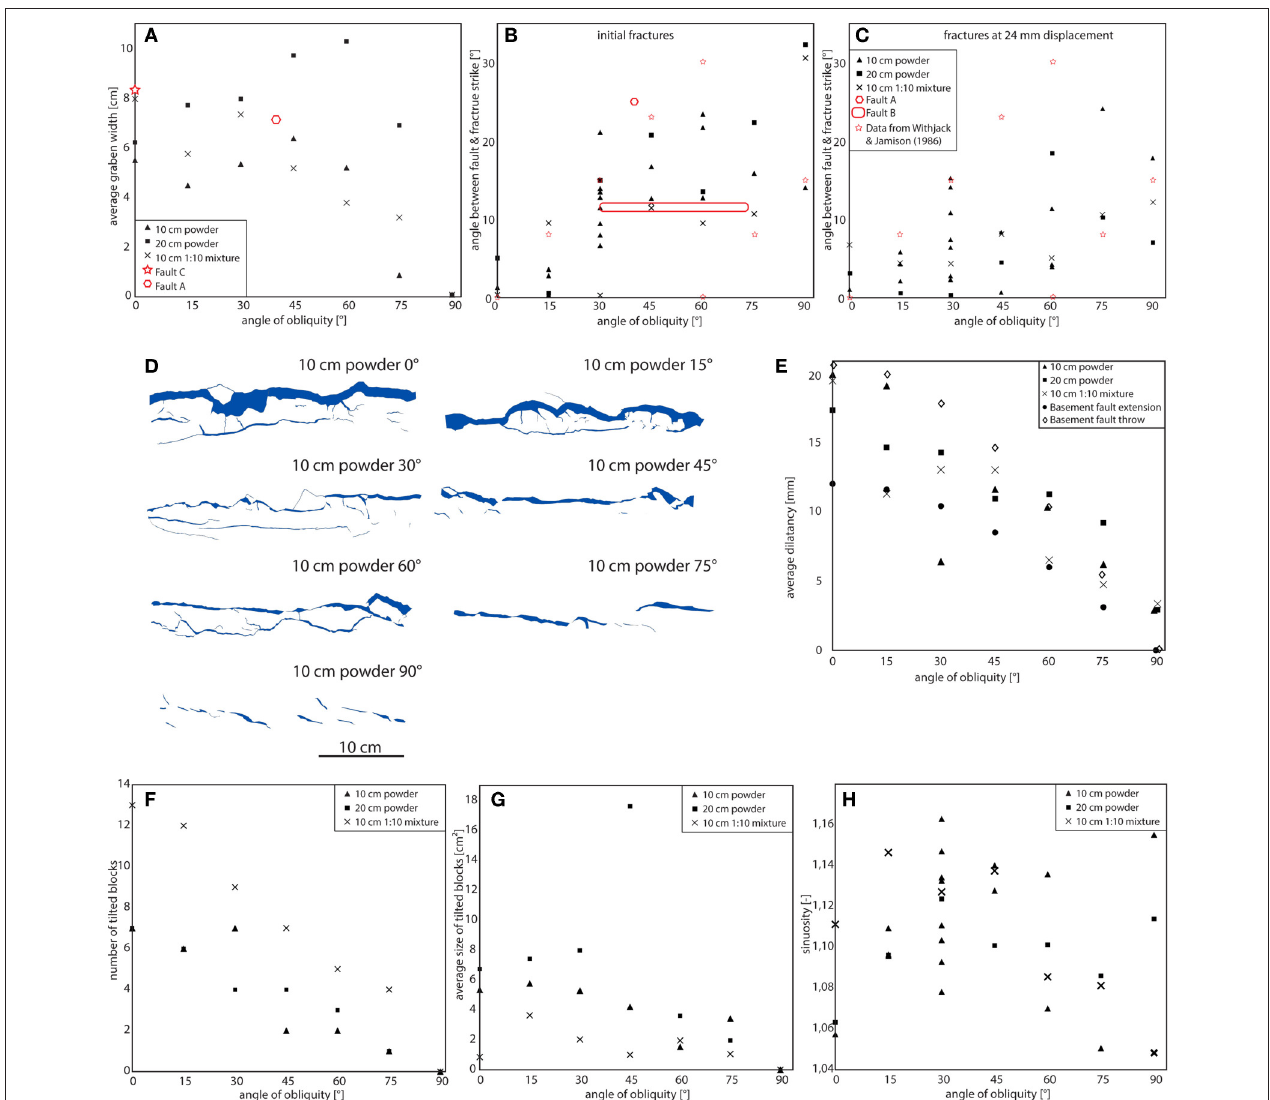
FIGURE 9 | Quantitative evaluation of all experiments. (A) Average graben width (i.e., the distance between the main fault and the antithetic fault) for experiments with 10 and 20cm powder thickness and 1:10 mixture experiments as a function of obliquity. Graben width is constant or slightly increasing for low to medium obliquities and drops to zero at high obliquities. No graben forms in strike-slip experiments. Faults (A,C) are natural examples from Iceland ( Figure 13 ). (B) Orientation of initial fractures for different obliquities as observed in experiments, as measured after 2mm of displacement. Progressive change of strike direction can be seen until ∼ 45 ◦ , after which the orientation is roughly constant at an angle of 15 ± 5 ◦ with respect to the basement fault. Red markers represents fracture orientation observed at an evolving fault in Iceland. (C) Orientation of fractures as observed after 24mm of displacement in experiments. Mean strike values are variable, but a general trend with increasing obliquity can be inferred. The values measured in our experiments are similar to values obtained from soft clay models (Withjack and Jamison, 1986) (D) examples of dilatancy as determined in 10cm powder experiments. Top view of experiments, blue areas are dilatant parts. (E) Quantification of changes of dilatancy with increasing obliquity. The general decreasing trend can be seen in all experiments. Dilatancy scales with horizontal displacement on the basement fault (black dots). (F) Number of tilted blocks plotted vs. fault obliquity. A general decrease is observed. The size of tilted blocks remains constant for low obliquities, but decreases slightly when obliquity is larger than 45 ◦ (G) . This trend is less apparent for 1:10 mixture experiments. (H) Fault sinuosity as a function of